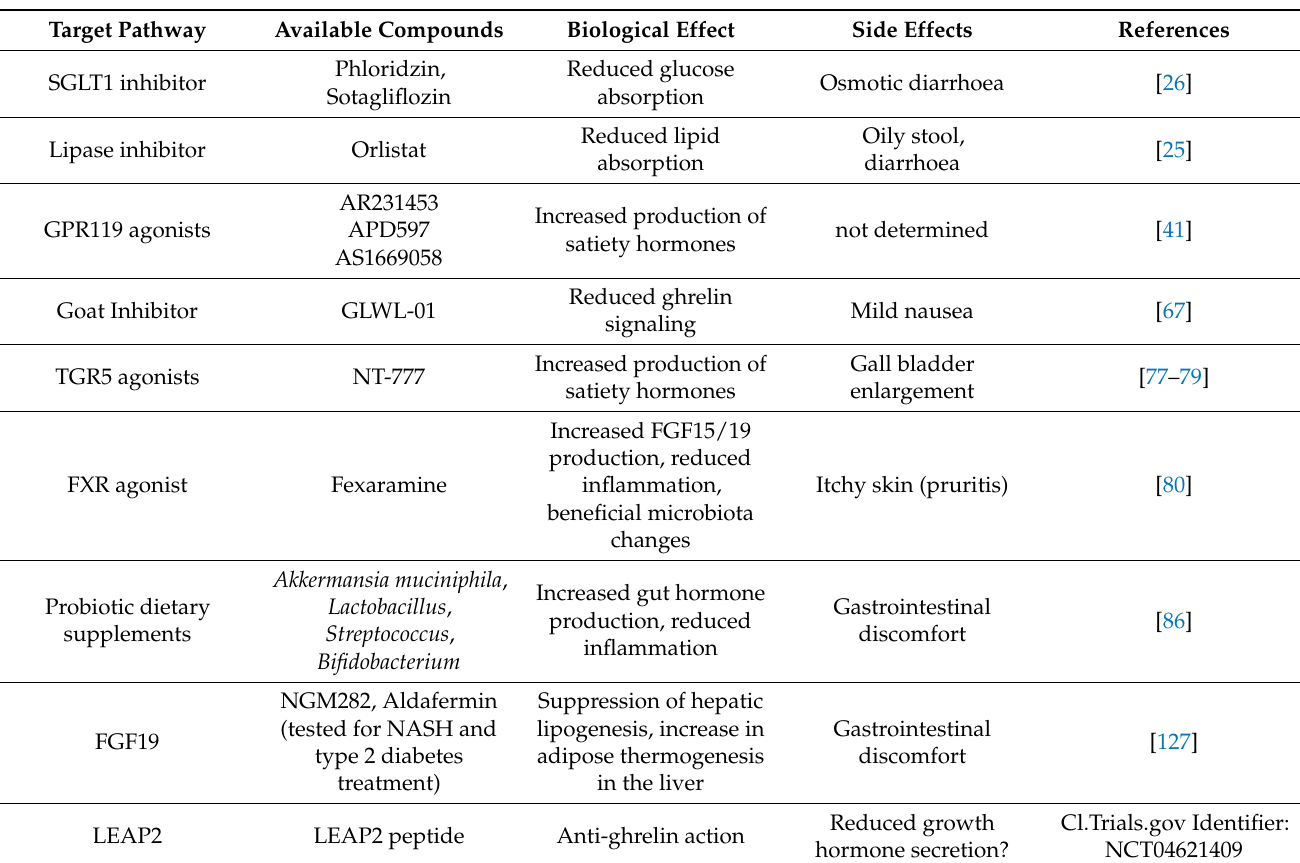
Table 1. Pharmacological compounds for obesity treatment mentioned in the